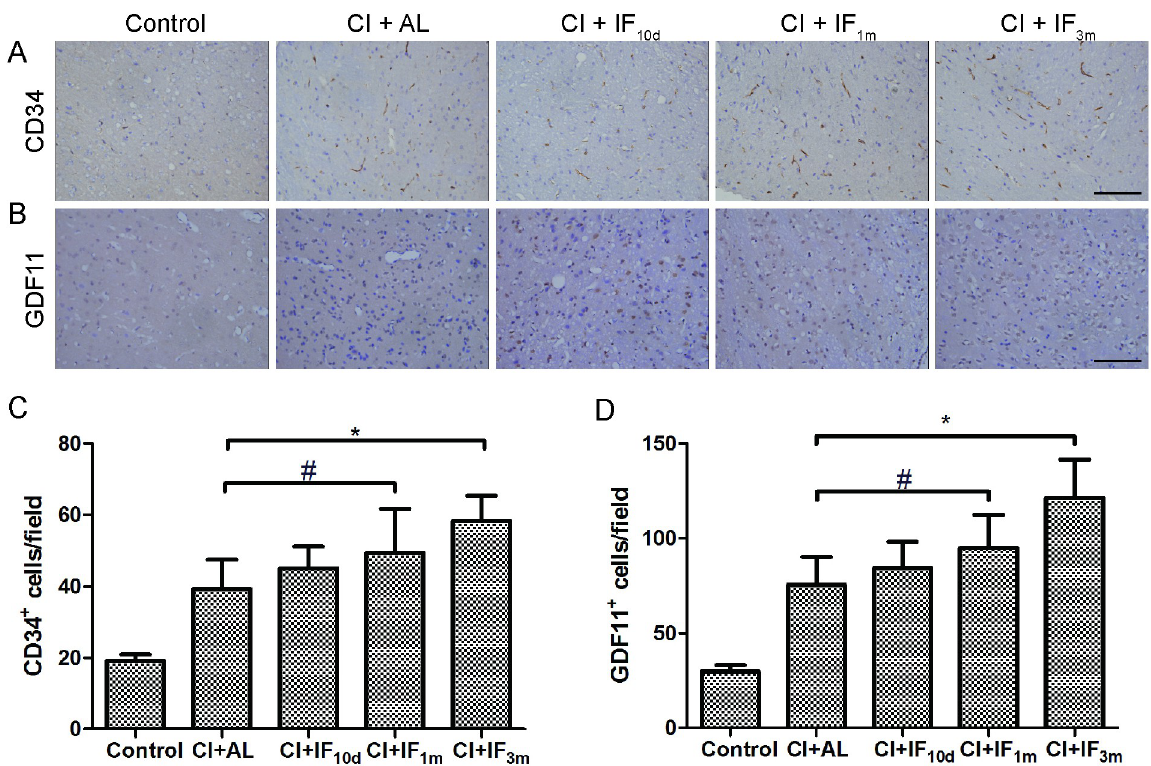
Fig 2. ( A ) Long-term IF conditioning promotes the expression level of cerebral CD34 7 d after MCAO. Scale bar, 100 μ m ( B ) Long-term IF conditioning promotes the expression level of cerebral GDF11 protein 3 d after MCAO. Scale bar, 100 μ m Representative images of immunohistochemistry for CD34 and GDF11 in the peri-infarct area are shown (original magnification × 400; scale bar, 100 μ m). Bar graphs showing the CD31 + ( C ) and GDF11 + ( D ) cells/mm 2 in the 5 groups. # p < 0.05, * p < 0.01 compared with the CI + AL group (n =